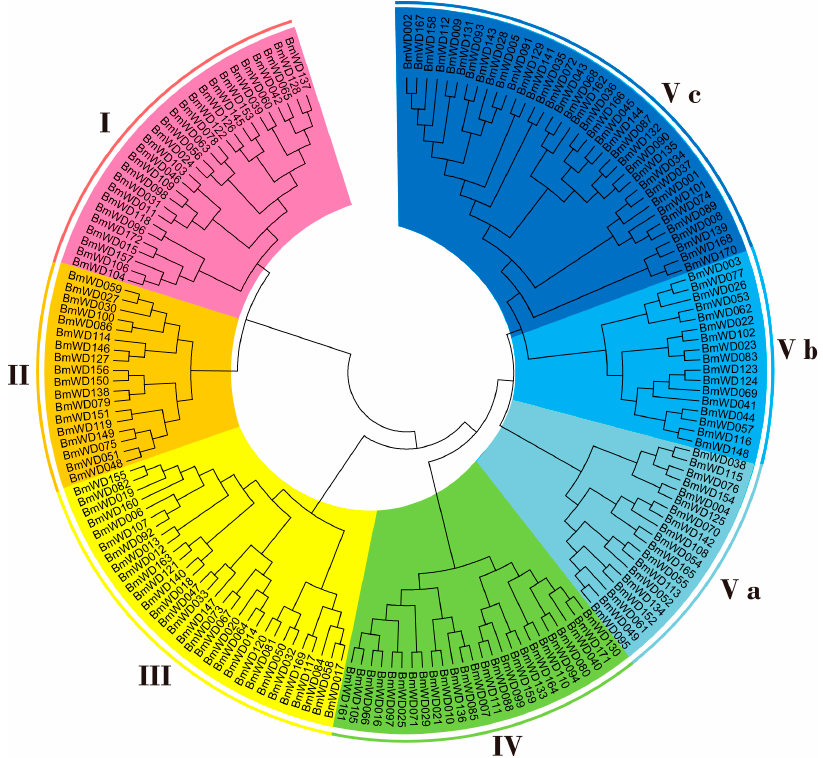
Figure 3. Phylogenetic classification of Bm WD40 proteins. MEGA6 (Molecular Evolutionary Genetics Analysis version 6.0, http://www.megasoftware.net/) was used to construct the phylogenetic tree using the neighbor-joining method with 1000 bootstrap replicates. The tree was divided into five main distinct clusters (Cluster I–V), and Cluster V was divided into three sub-clusters (Clusters Va, Vb and Vc). Vb and